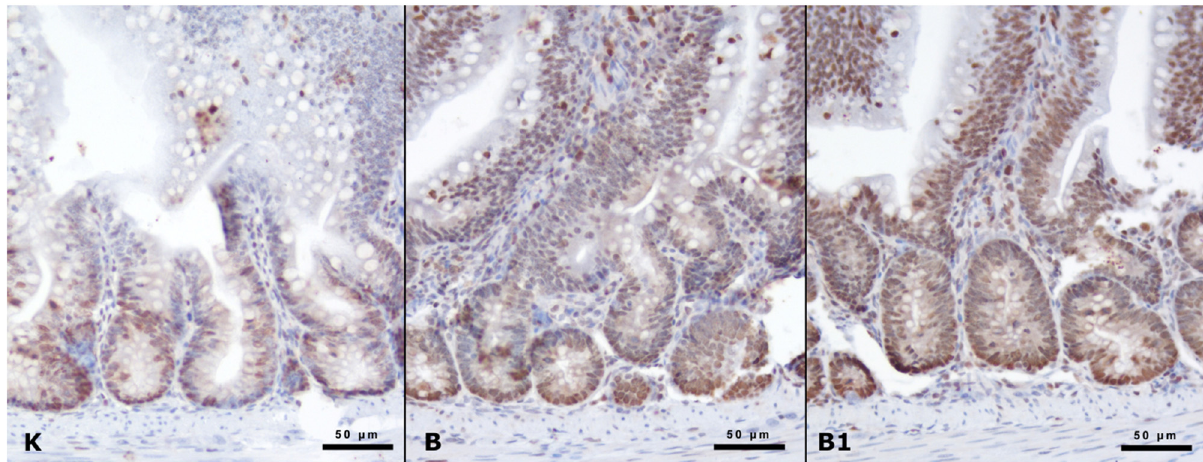
Figure 2: Microscopic image of PCNA immunohistochemical staining of group jejunum. In Bor 0.5 ( B ) and Bor 1 ( B1 ) groups, more intense PCNA positivity ( nuclear red color indicates positivity ) is observed compared to the control group ( K ) . ABC - peroxidase technique, AEC chromogen, Mayer ’ s hematoxylin. Bar = actual